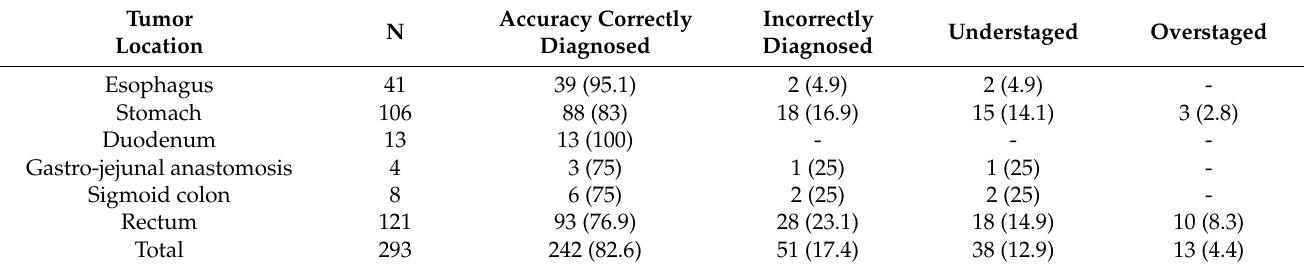
Table 4. The proportion of corrected diagnosis for tumor depth by EUS compared with the pathologic results. Values are reported as numbers